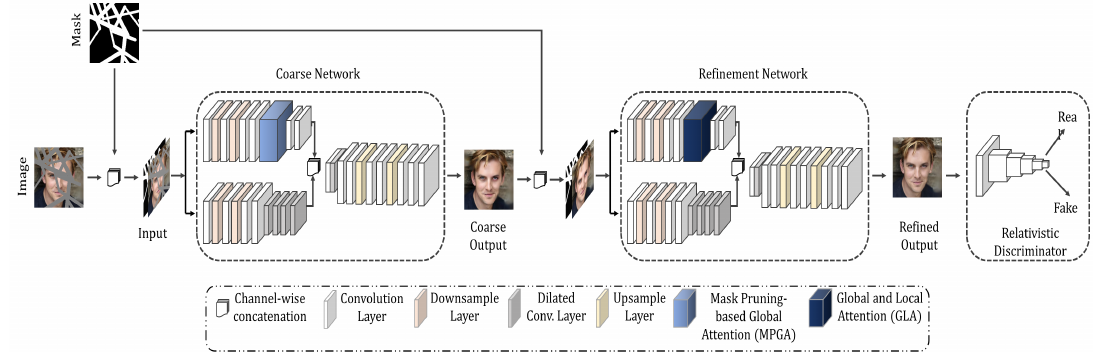
Figure 2. Overall architecture of the proposed model. The proposed model has two stages, namely a coarse network and a refinement network. Both the coarse and refinement networks have two branches, namely a regular branch and an attention branch. The coarse network calculates the global dependencies among the features and prunes out mask features using the proposed MPGA module, generating a rough or coarse inpainted image. The refinement network takes the coarse output as the input and calculates both global and local similarities using the proposed GLA module and produces a refined inpainting